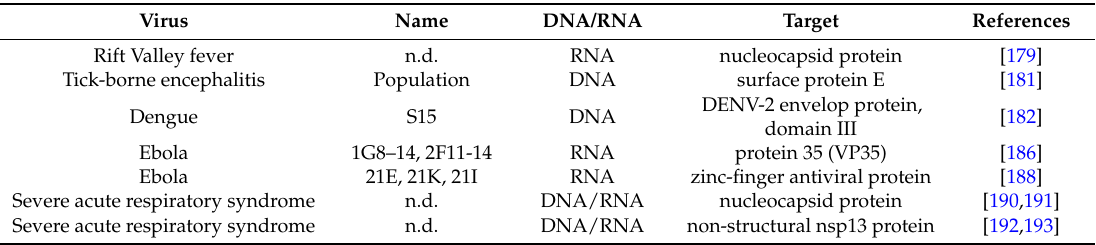
Table 7. Summary data on the aptamers selected against emerging viruses discussed